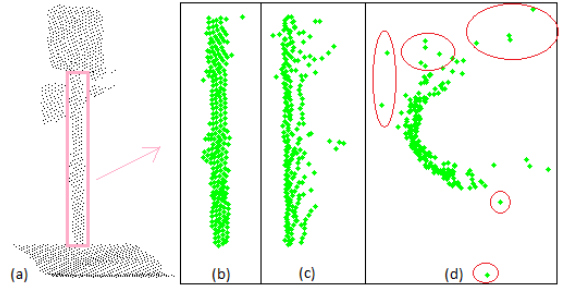
Figure 1. (a) Mobile laser scanned signpost; incomplete point cloud data, (b) a segment (cylindrical part; front view) of the data, (c) cylindrical data; side view, and (d) cylindrical data; top view, outliers are highlighted by red